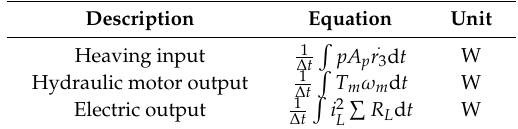
Table 3. Equations set to calculate the experimental averaged power.